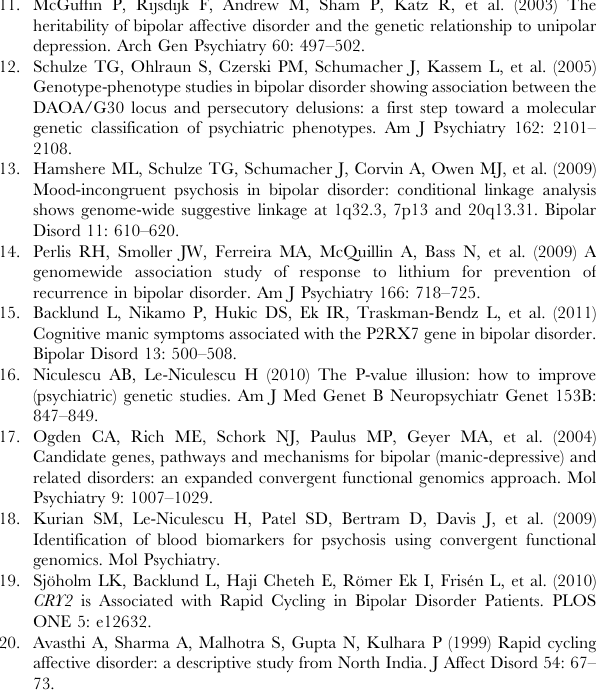
Table S1 Expression data for P2RX7 listed in a MIAME compliant format. Raw and normalized data for each 71 samples 6 24 probesets covering 18 exons is listed. The 71 samples consist of 8 individuals (subjects) sampled at 9 time